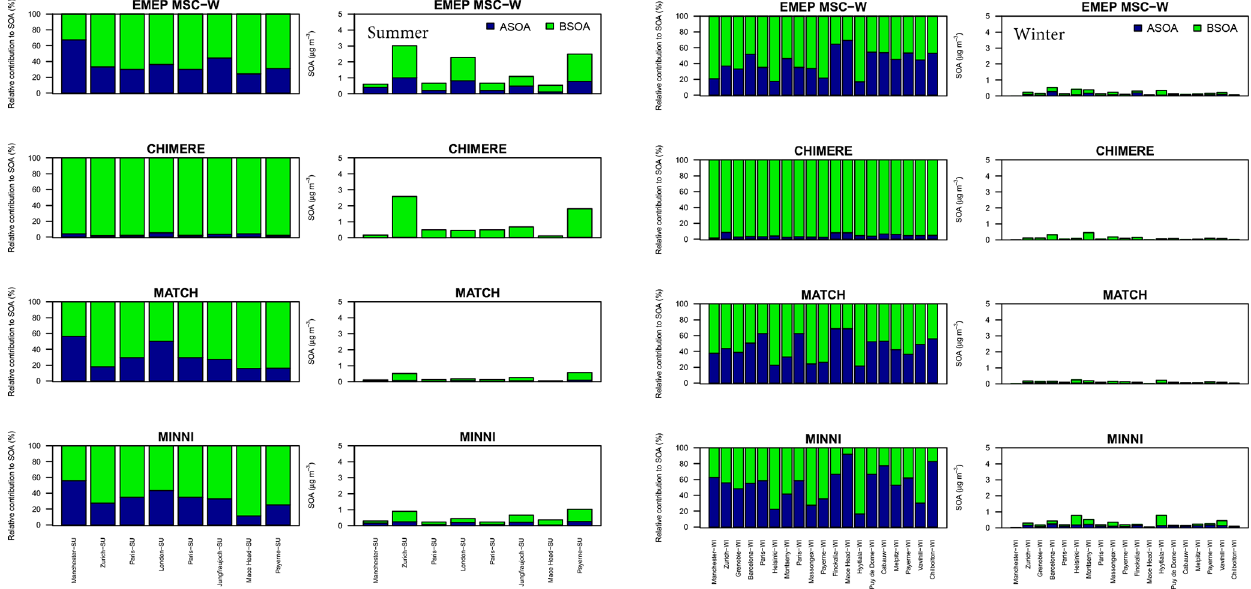
Figure 15. Modeled relative and absolute ASOA and BSOA fractions for summer (left panels) and winter (right panels) for different years (between 2000 and 2010) and seasons of the year (Table